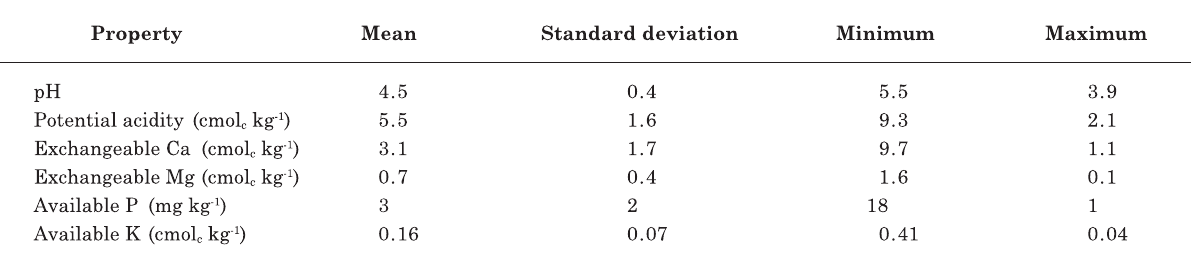
Table 1. Mean values of the chemical properties of the soils of the 65 studied